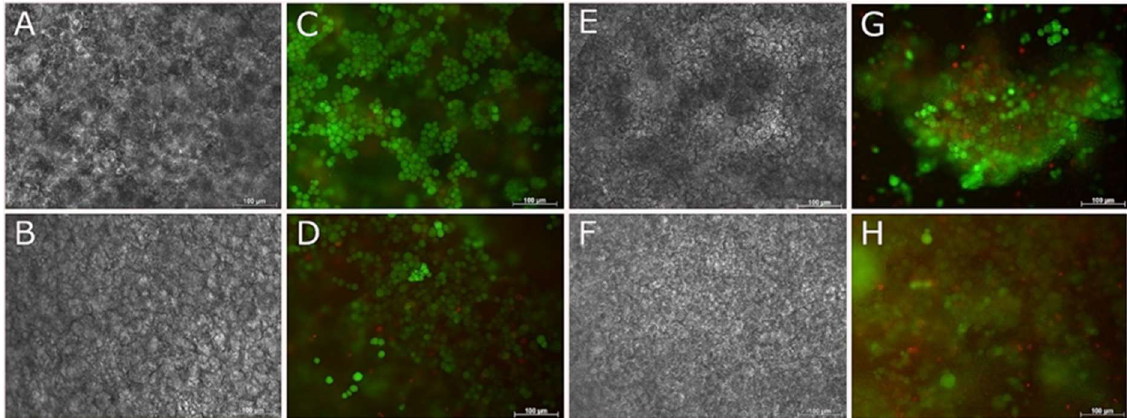
Figure 7. Live and Dead and phase contrast images of NSC-34 cells encapsulated in 2.5/mL fish collagen. Phase contrast ( A , B , E , F ) and live and dead ( C , D , G , H ) images taken of NSC-34 at 7 ( A – D ) and 14 ( E – H ) days. Top and bottom rows correspond to cells cultured with differentiation media and growth media, respectively. Scale bars represent 100 µm.